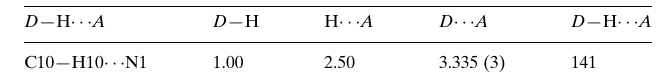
Hydrogen-bond geometry (A˚ , (cid:3)